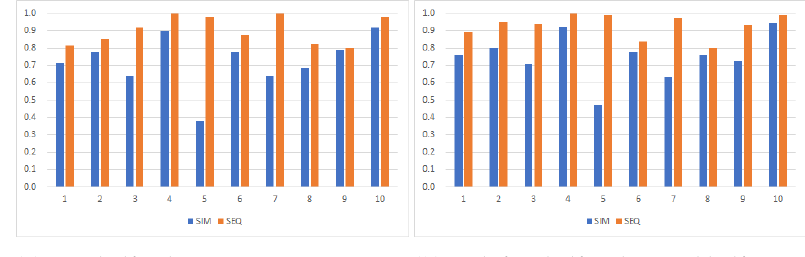
Figure 2. Social Surplus Rate.